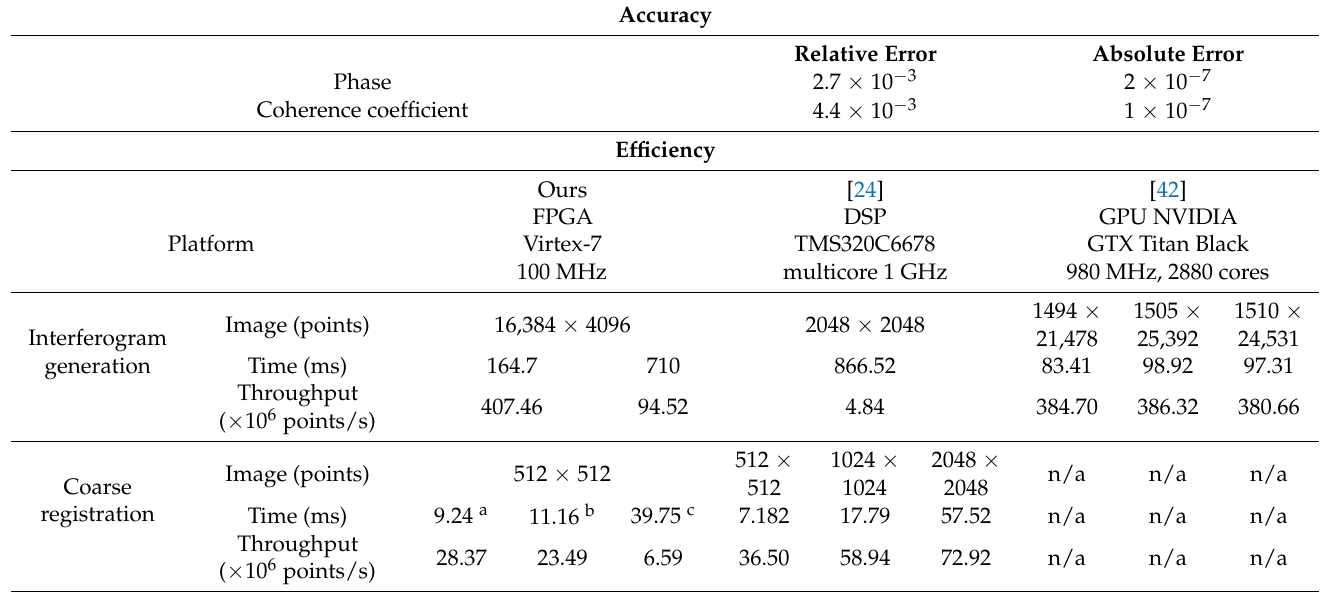
Table 11. Comparison of the accuracy and efficiency of FPGA, DSP, and